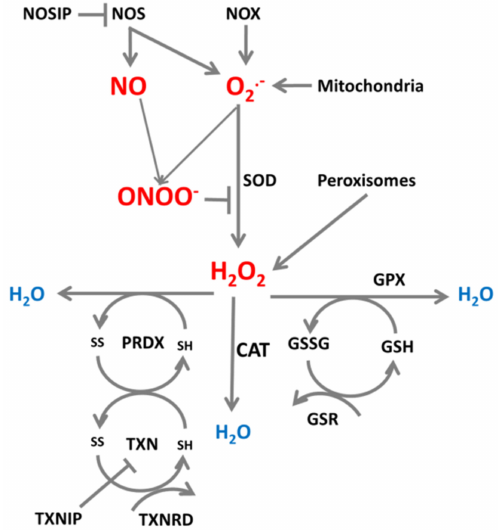
Figure 1. ROS/RNS production and neutralization. Cellular superoxide (O 2 •− ) and nitric oxide (NO) and produced and further converted to peroxynitrite (ONOO - ) by reaction of NO with O 2 •− , or to H 2 O 2 by superoxide dismutase (SOD). H 2 O 2 can be further neutralized to H 2 O by catalase (CAT), glutathione peroxidase (GPX) and peroxiredoxins (PRDX) which are reduced by thioredoxins (TXN). TXN is reduced by thioredoxin reductase (TXNRD) and glutathione (GSH) is reduced by glutathione-disulfide reductase